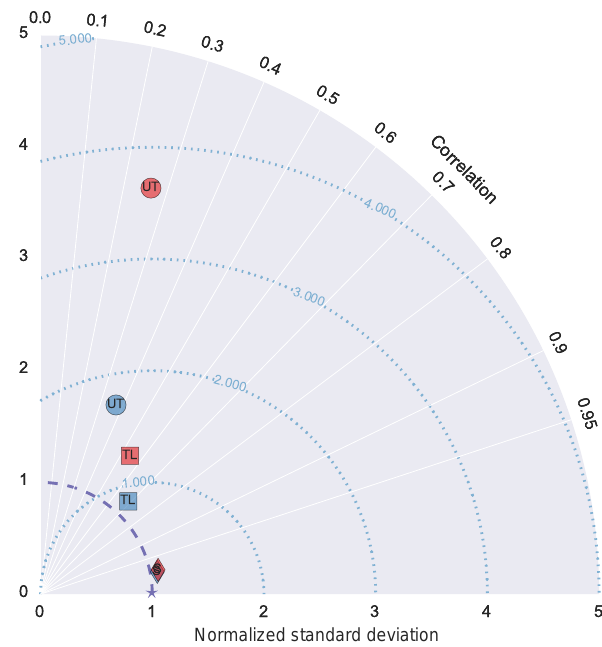
Figure 12. As in Fig. 5, but for